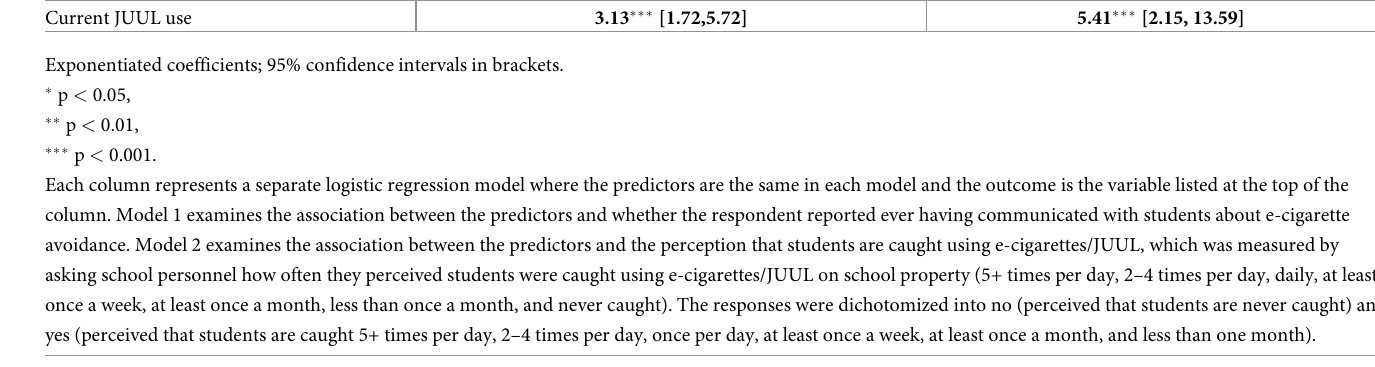
Table 5 explores predictors of intervention on student e-cigarette use among school person- nel who reported that their school had an e-cigarette policy. Among these respondents, odds of communicating with students about e-cigarette avoidance generally increased if they had training on their school’s policy (OR = 3.22, CI = 2.41, 4.31), higher perceived severity of stu- dent e-cigarette use (Very serious problem: OR = 15.00, CI = 8.31,27.08), or currently used JUUL (OR = 2.51, CI = 1.30, 4.85). Respondents who reported working in a middle school and